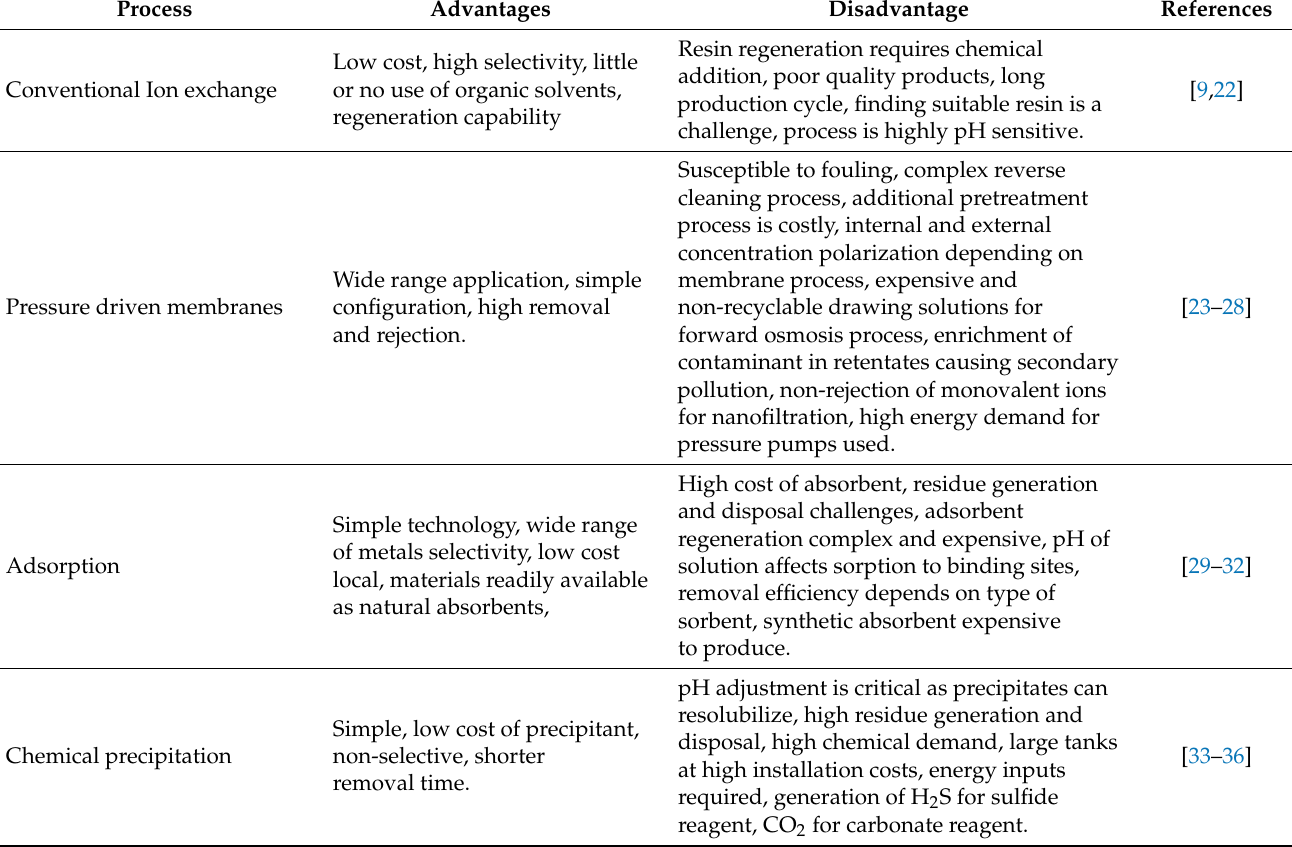
Table 1. Advantages and disadvantages of selected metal removal technologies.